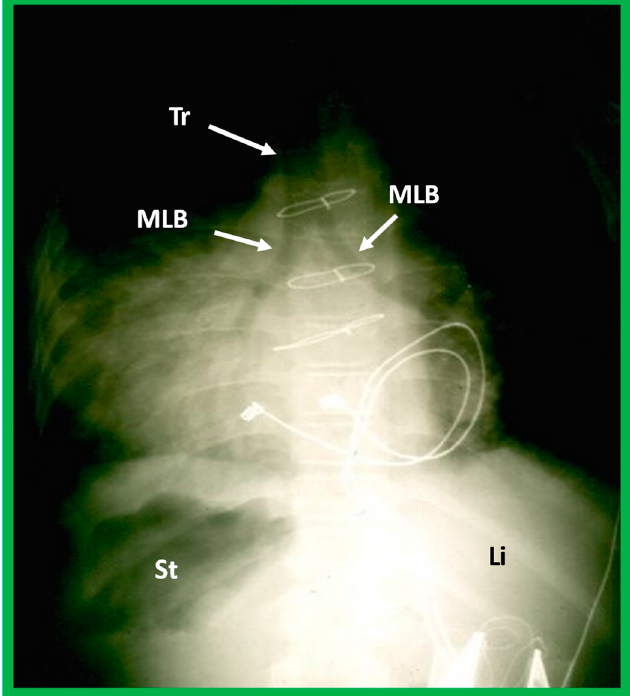
Figure 24. A chest roentgenogram of a patient with situs inversus demonstrating left-to-right rever- sal of the normal bronchial pattern; the morphologically right bronchus (RB) is on the left side, and the morphologically left bronchus (LB) is on the right side. The left-to-right inversion of the viscera with the liver (Li) on the left and the stomach (St) on the right indicates situs inversus. The heart (H) is in the right hemithorax (dextrocardia). Modified from reference [4].